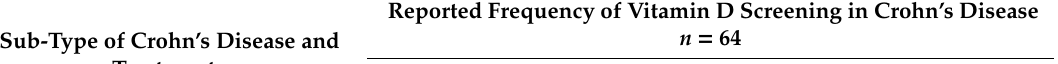
Table 2. Reported Frequency of Vitamin D